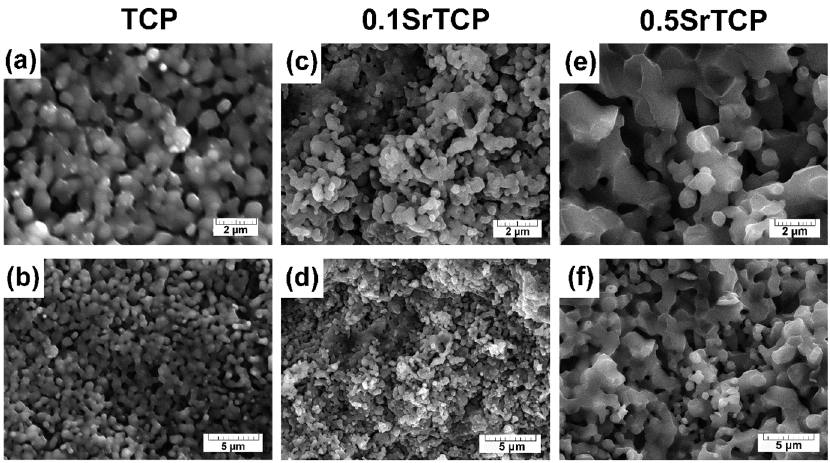
Figure 4. SEM images of TCP ( a , b ), 0.1SrTCP ( c , d ), and 0.5SrTCP ( e , f ) ceramics sintered at 1100 °C at 2 and 5 μ m resolution. Table 2. Chemical composition of TCP and SrTCP samples obtained by EDX and ICP ‐ OES data. The values are given with a relative error of 0.05%.